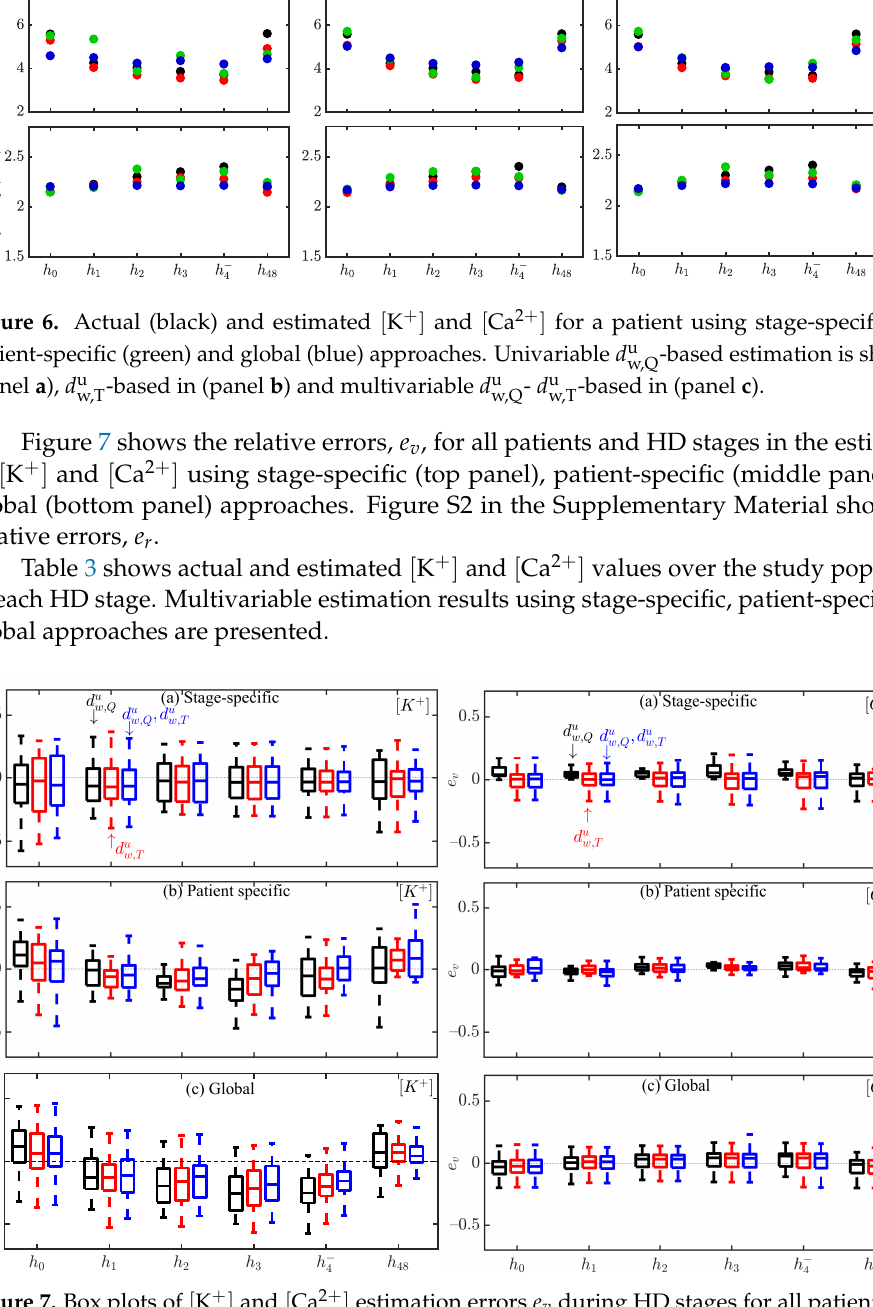
and d u (blue) for stage-specific ( top ), patient- w,T w,Q